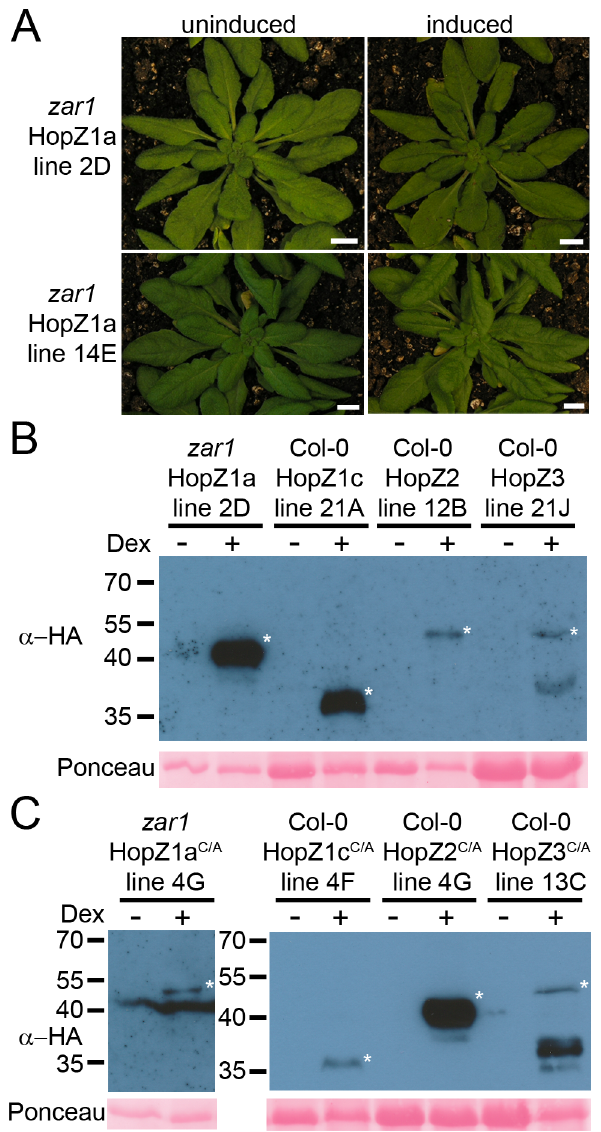
Fig. 2. Transgenically expressed HopZ1a in Arabidopsis zar1 background does not induce an HR. (A) Phenotype of transgenic HopZ1a and HopZ1a C/A in zar1-1 plants 24 hours after transgene induction by spraying with 30 m M dexamethasone. (B–C) Immunoblot analysis of HopZ (B) and HopZ C/A (C) proteins expressed in transgenic lines after treatment with 30 m M dexamethasone or water. Transgenic HopZ1a is in a zar1-1 background while HopZ1c, HopZ2 and HopZ3 are in a Col-0 background. The Ponceau Red stained blot serves as the loading control. The expected sizes are as follows: HopZ1a-HA 42.1 kDa, HopZ1c-HA 30.5 kDa, HopZ2-HA 41.9 kDa, HopZ3-HA 46.9 kDa, and the expected band is marked with an